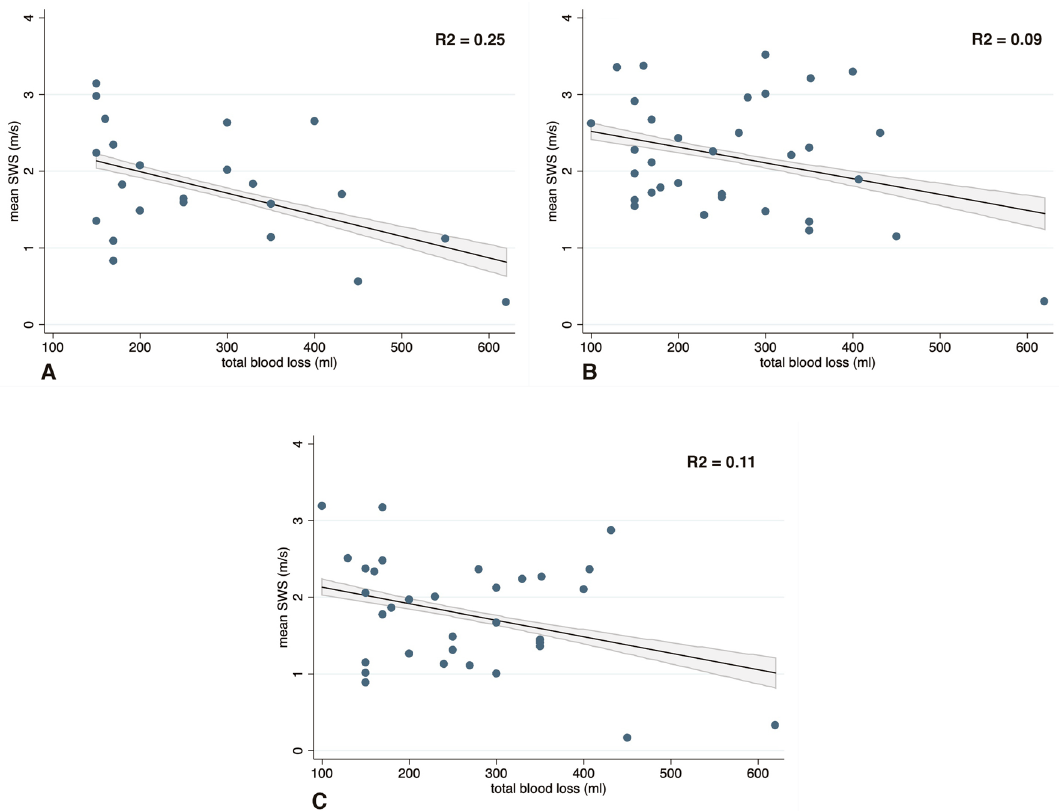
Figure 3. Mean SWS and total blood loss. Relationship between mean SWS and total blood loss between at the three different time points. The figure illustrates the ‘‘FitPlot’’ consisting of scatter plots of the data overlaid with the regression line, and 95% confidence interval. Correlation coefficients are reported (R 2 ). ( A ) Before placental expulsion. ( B ) Immediately after placental expulsion. ( C ) 30 min after placental expulsion.